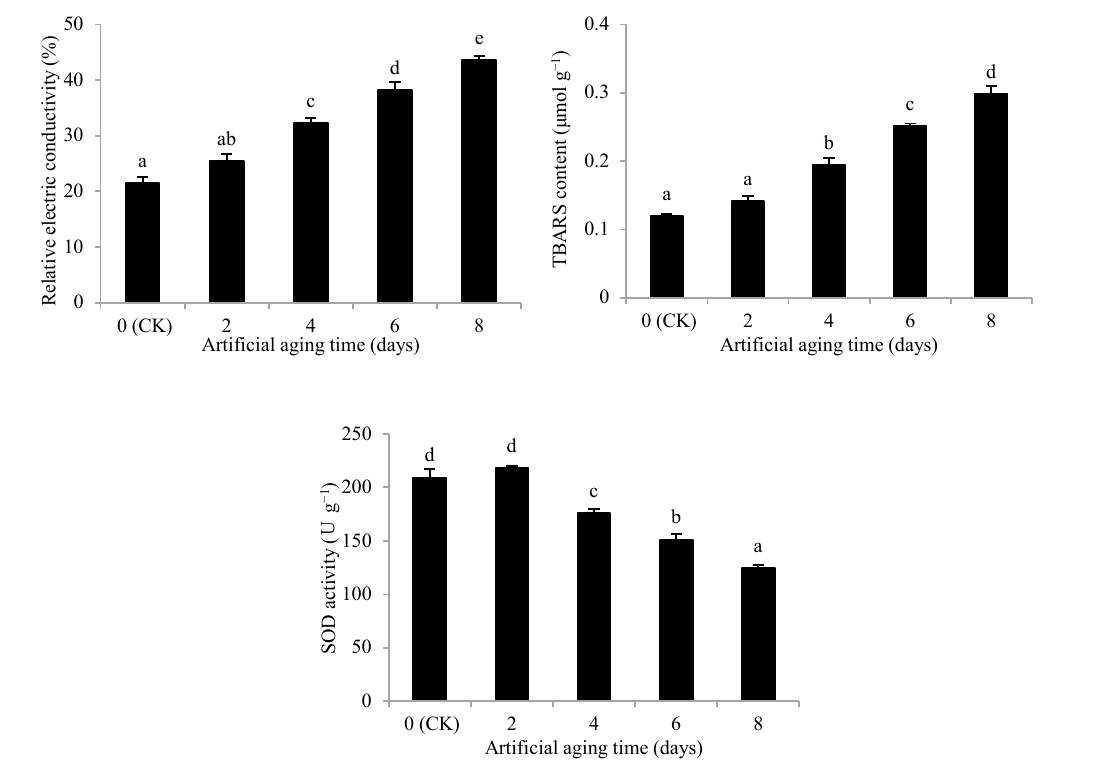
Figure 2 Effects of artificial aging on relative electric conductivity, thiobarbituric acid (TBARS) content, and superoxide dismutase (SOD) activity in Aegilops tauschii seeds. e values are shown as mean ± SE . Different letters above the bars denote significant differences ( p ≤ 0.05) with Duncan’s test within the same planting